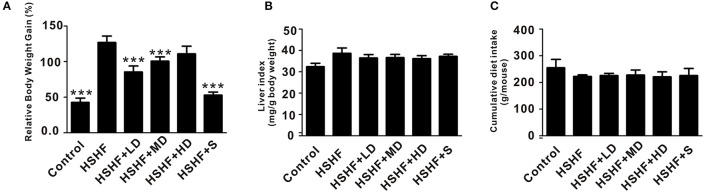
Effects of krill oil treatment on the physical features of mice fed the HSHF diet. (A) The relative body weight gain of HSHF diet fed mice with krill oil supplementation. (B) Liver index of HSHF diet fed mice with krill oil supplementation. (C) Total food intake of HSHF diet fed mice with krill oil supplementation. TC, total cholesterol. TG, triglyceride. HDL, high-density lipoprotein. LDL, low-density lipoprotein. Data are presented as the means ± S.D. Differences were assessed by ANOVA. ***P < 0.001 vs. HSHF group.